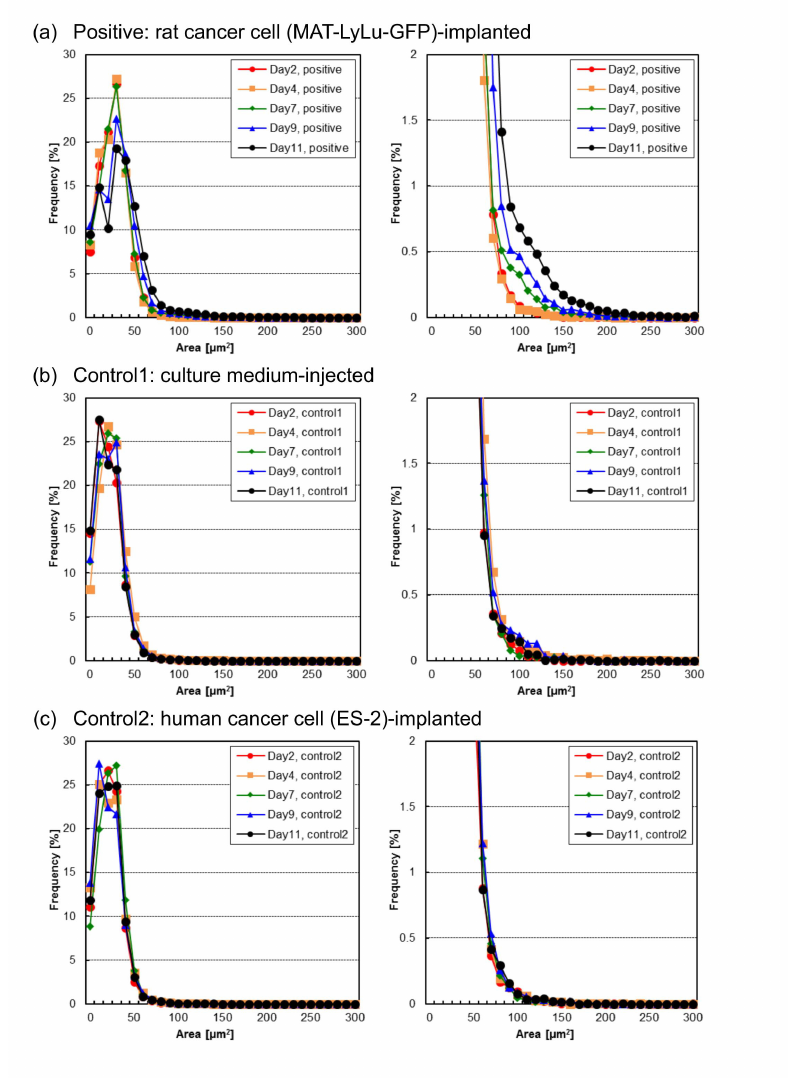
Figure 11. Time-course change of the distribution of total nucleus area in positive ( a ), control 1 ( b ), and control 2 ( c ) blood of the same samples as in Figure 4. Each nucleus area distribution map is from 2, 4, 7, 9, or 11 days after the implantation of rat cancer cells ( a , positive), culture medium ( b , control 1), or human cancer cells ( c , control 2). Measurements were performed for six rats for positive cases and three for controls. The graphs on the right are magnified versions of those on the